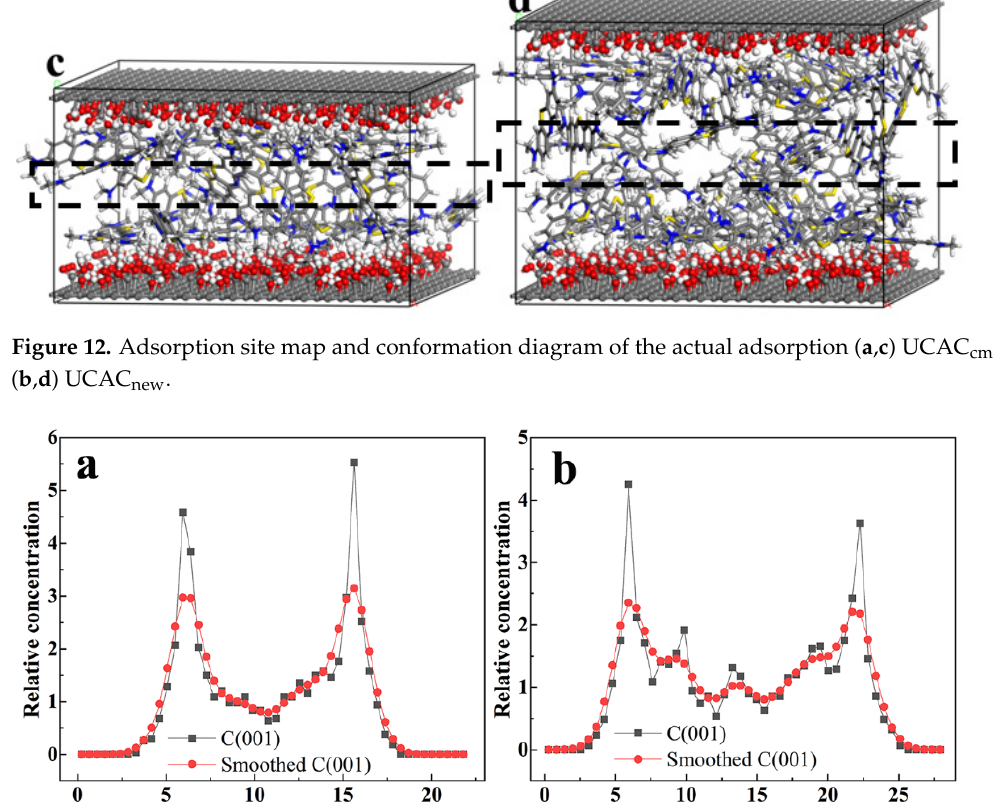
Figure 12. Adsorption site map and conformation diagram of the actual adsorption ( a , c ) UCAC cm ( b , d ) UCAC new.